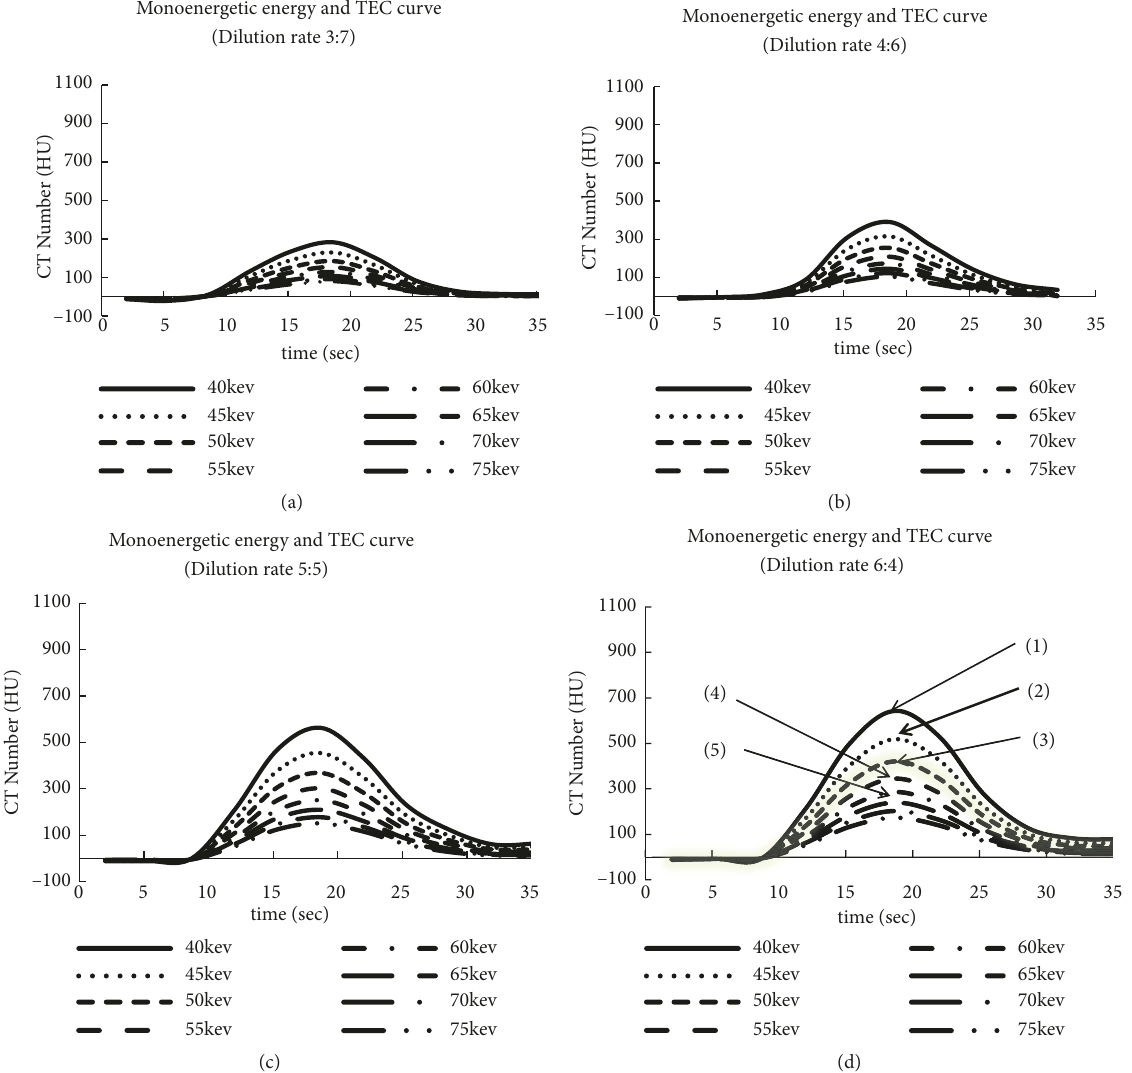
Figure 5: Monoenergetic energy and TEC. (a) Dilution rate 3:7; (b) dilution rate 4:6; (c) dilution rate 5:5; (d) dilution rate 6:4.